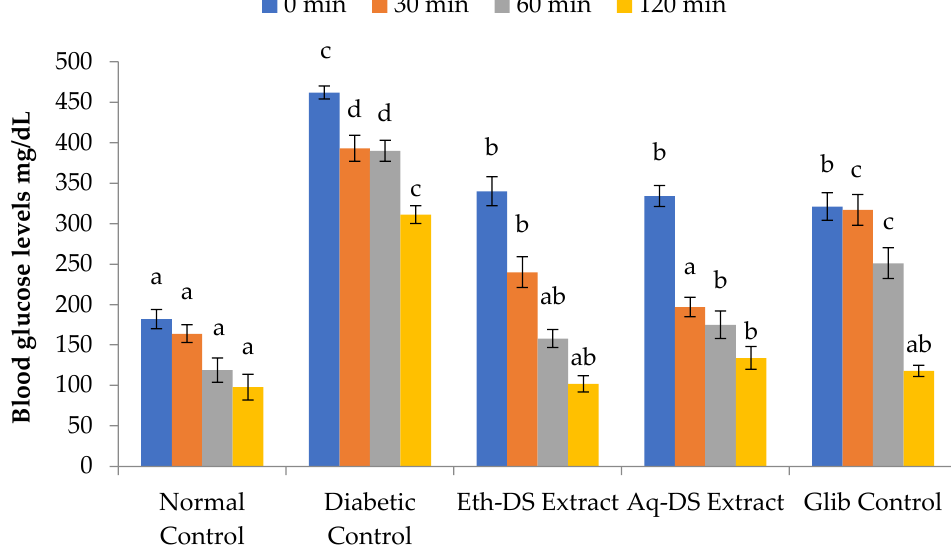
Figure 6. Comparative study of variability in glucose tolerance levels at various time intervals. A relatively maintained level of blood glucose in Eth-DS, Aq-DS extracts treated groups and in Glib control mice in sharp contrast to elevated blood glucose levels in diabetic mice. Different letters indicate significant difference among groups. (Eth-DS: Ethanolic extract of D. stewartii , Aq-DS: Aqueous extract of D. stewartii , Glib: glibenclamide treated group).